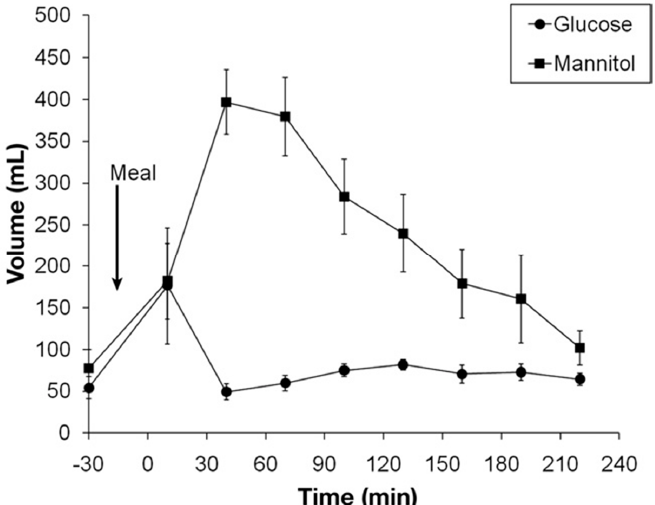
Figure 6. Postprandial time profile of small bowel water content (SBWC) in mL after ingestion of a 350 mL 5% glucose or mannitol test meal. While the glucose solution is absorbed almost as soon as it leaves the stomach the osmotically active but unabsorbable mannitol causes marked water secretion quadrupling the SBWC. Reproduced from [ 23 ], Elsevier 2010, with permission.